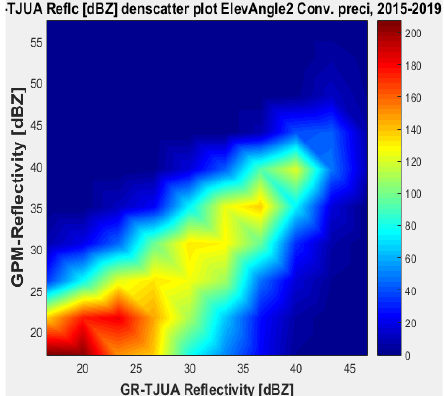
Figure 14. GPM ‐ Ku vs. NEXRAD TJUA for convective precipitation (angle 2).